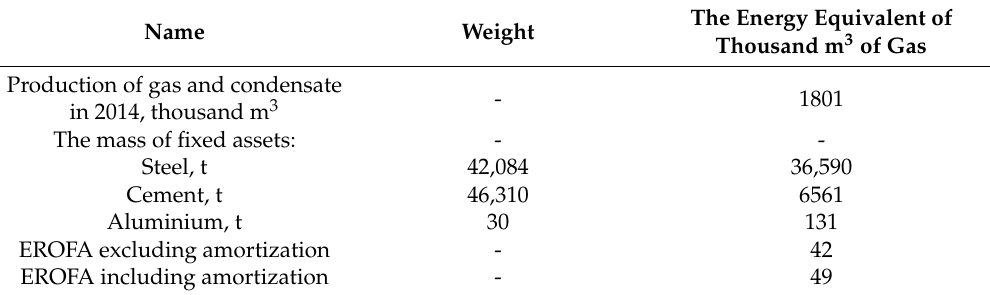
Figure 5. Dynamics of indicators of ROFA. Table 4. The converted data and the EROFA value in 2014.